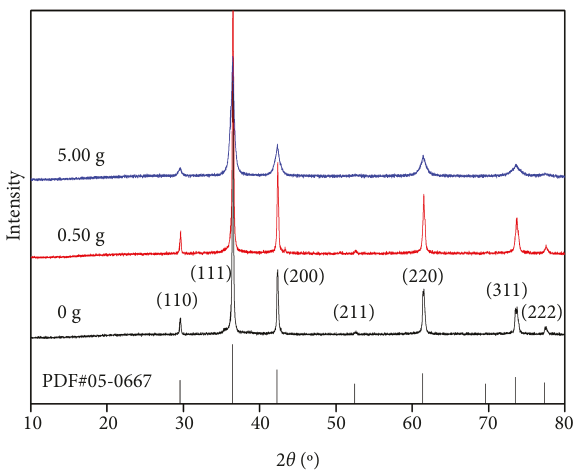
Figure 3: Effect of PVP dosage on the crystal structure of the reaction products (C2, C4, and